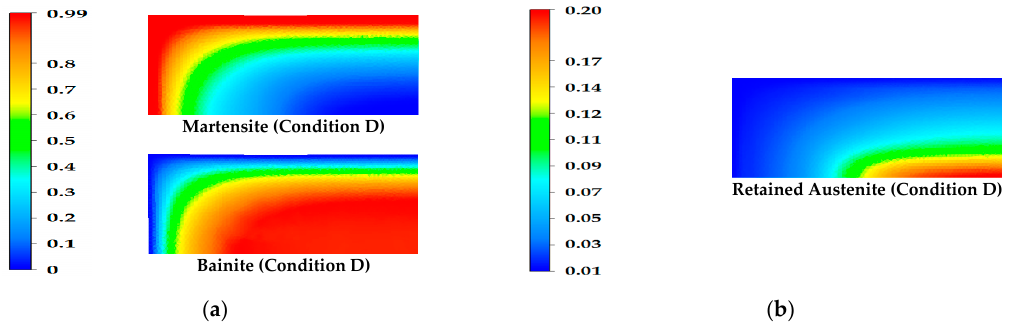
Figure 9. Distribution of phased transformed in section A-A (1/8 model) after the quenching process for simulation condition D (variable grain size and %C). ( a ) Contour of martensite and bainite distributions; ( b ) Contour of retained austenite distribution.